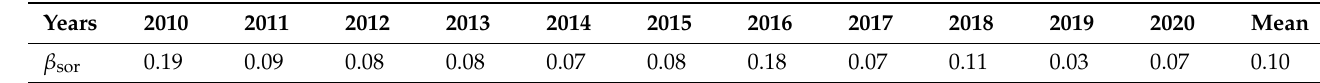
Table A4. Dissimilarity between spring and autumn per